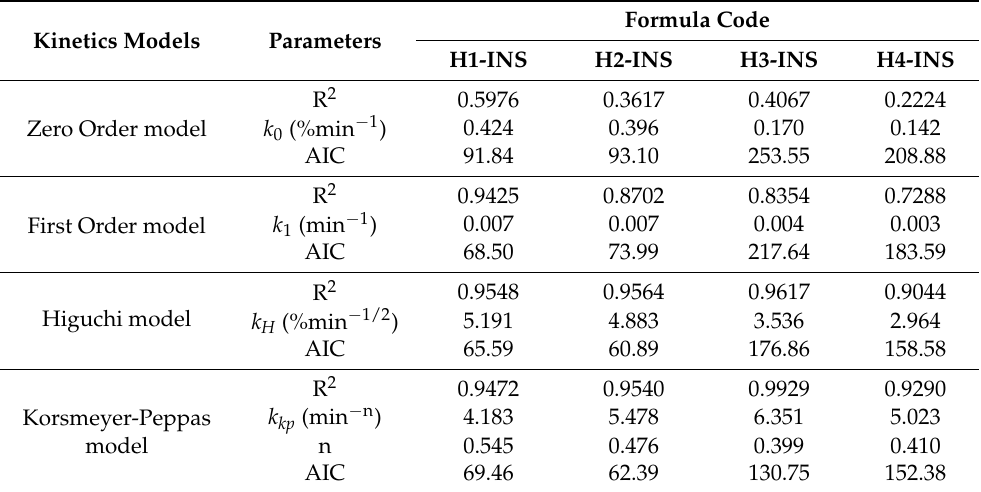
Table 2. Kinetic parameters and fitting of mathematical models to the data of insulin release from selected hydrogels. Kinetics Models